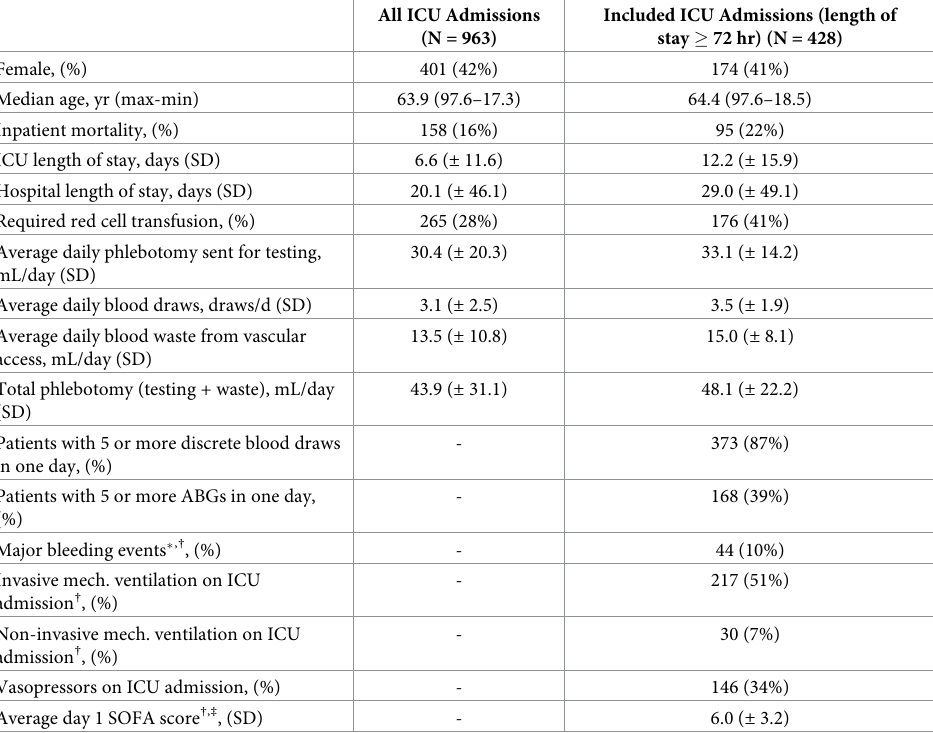
Table 1. Cohort characteristics for ICU admissions from Sept 1, 2014 to August 31,